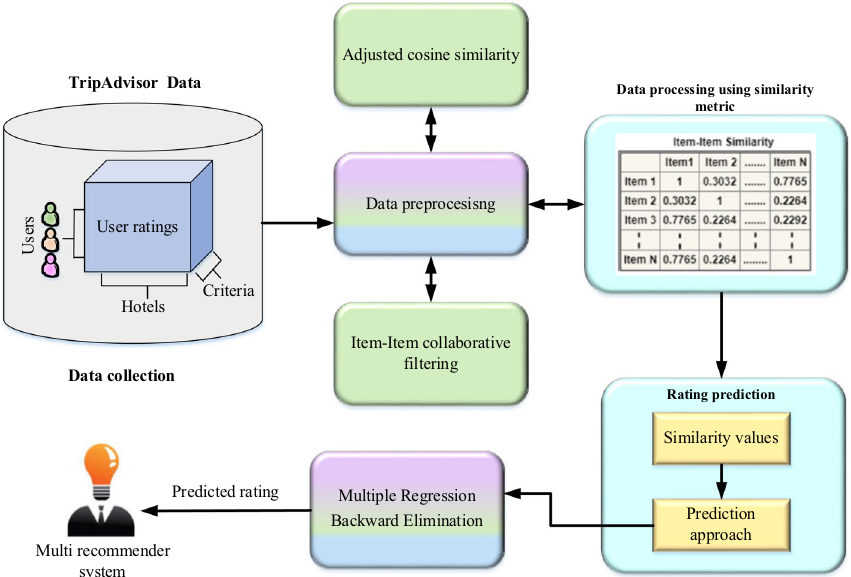
Fig. 1 Global architecture of the proposed